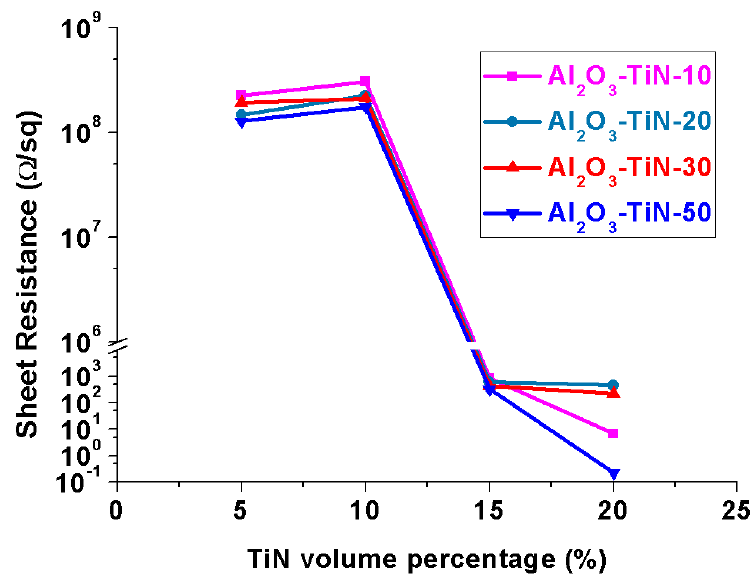
Figure 6. The comparison of the electrical property of the Al 2 O 3 –TiN ceramic composites fabricated from Al 2 O 3 –Ti precursor powders with 5, 10, 15 and 20 vol % Ti-10, Ti-20, Ti-30 and Ti-50 additives, respectively.